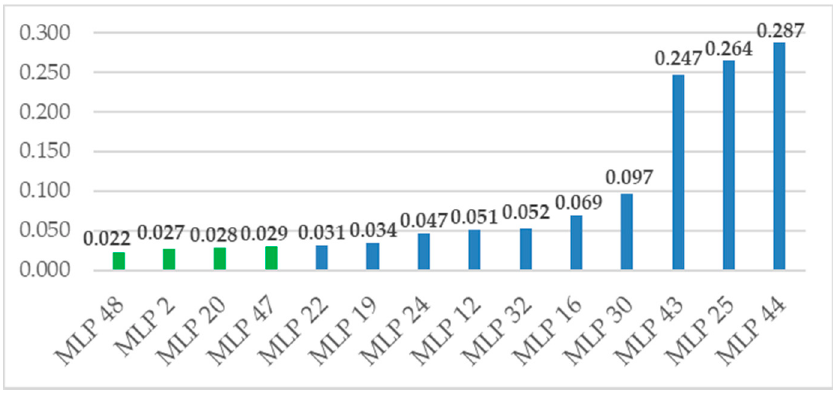
Figure 9. Value of mean square error (MSE) error for verification artificial neural networks Figure9. (ANN) models.